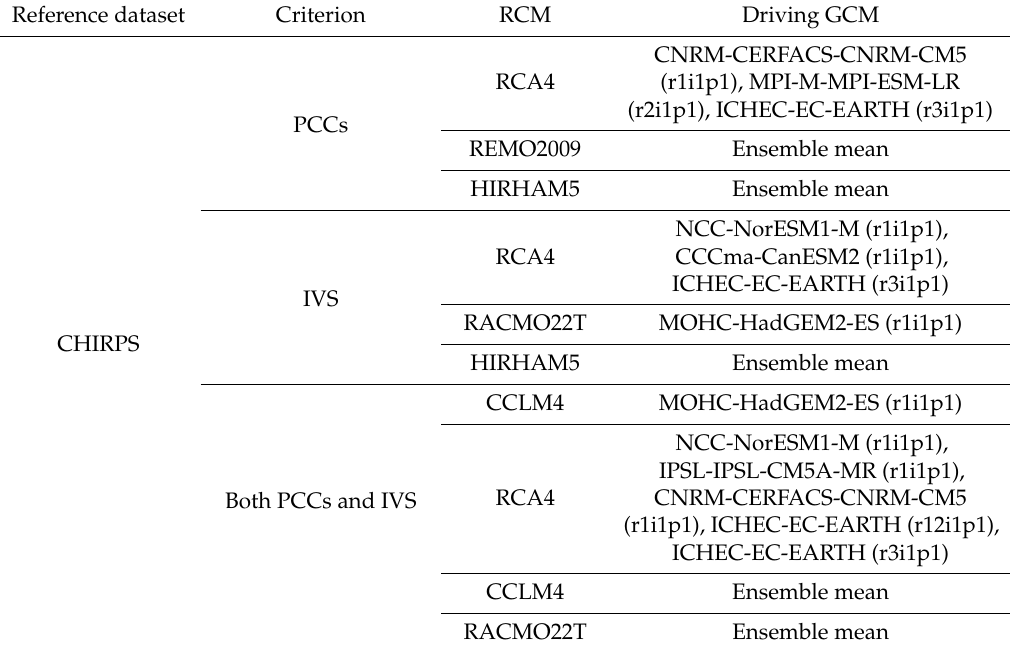
Table 3. Top RCM runs per criteria for north West Africa